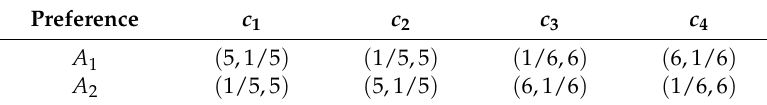
Table 4. The incomparability relation between A 1 and A 2 .